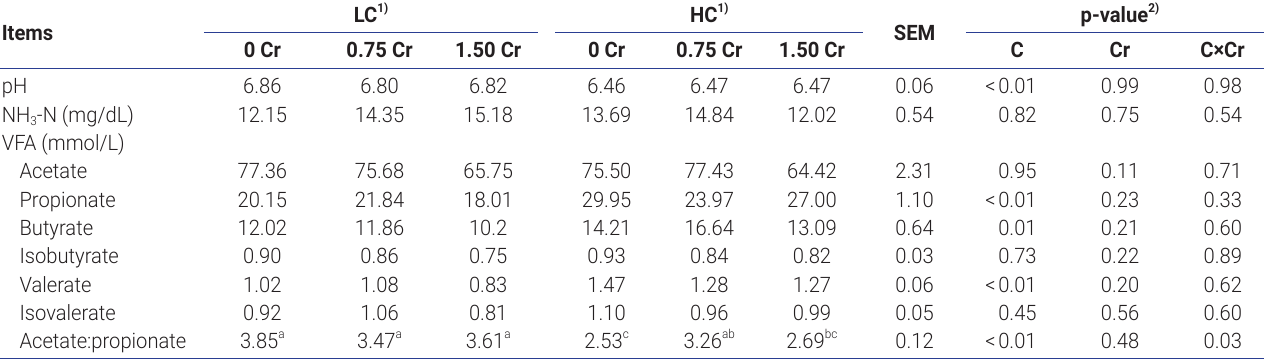
Table 4. Effects of concentrate level and Cr-Met supplementation on rumen fermentation characteristics of Tan lambs